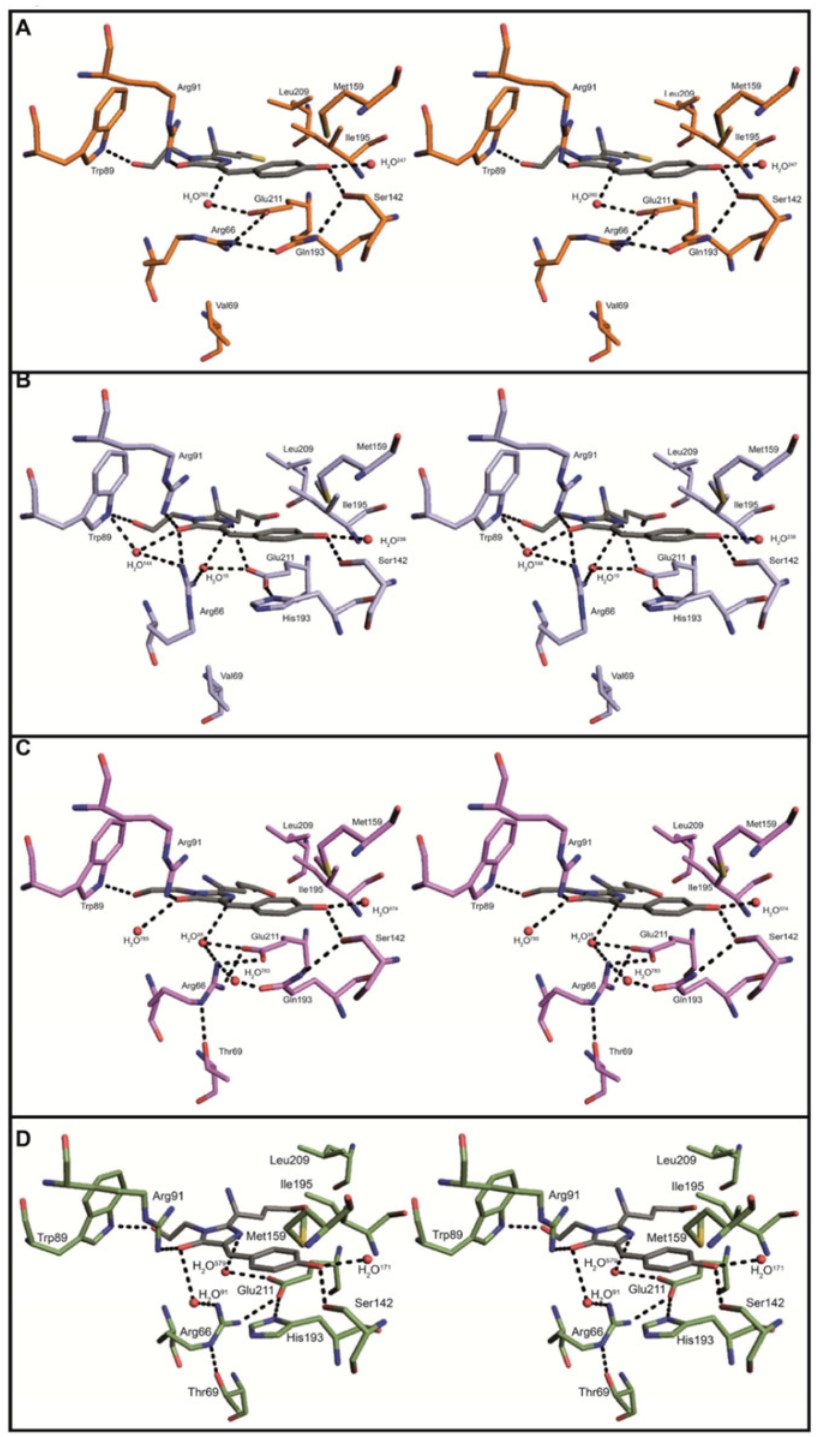
Fig 3. The chromophore environment of Phanta, eCGP123 T69V , eCGP123 H193Q and eCGP123. Stereoviews are shown comparing the chromophore environments and hydrogen bond networks for (A) Phanta; (B) eCGP123 T69V ; (C) eCGP123 H193Q and (D) eCGP123. Numbered waters are shown as red spheres.